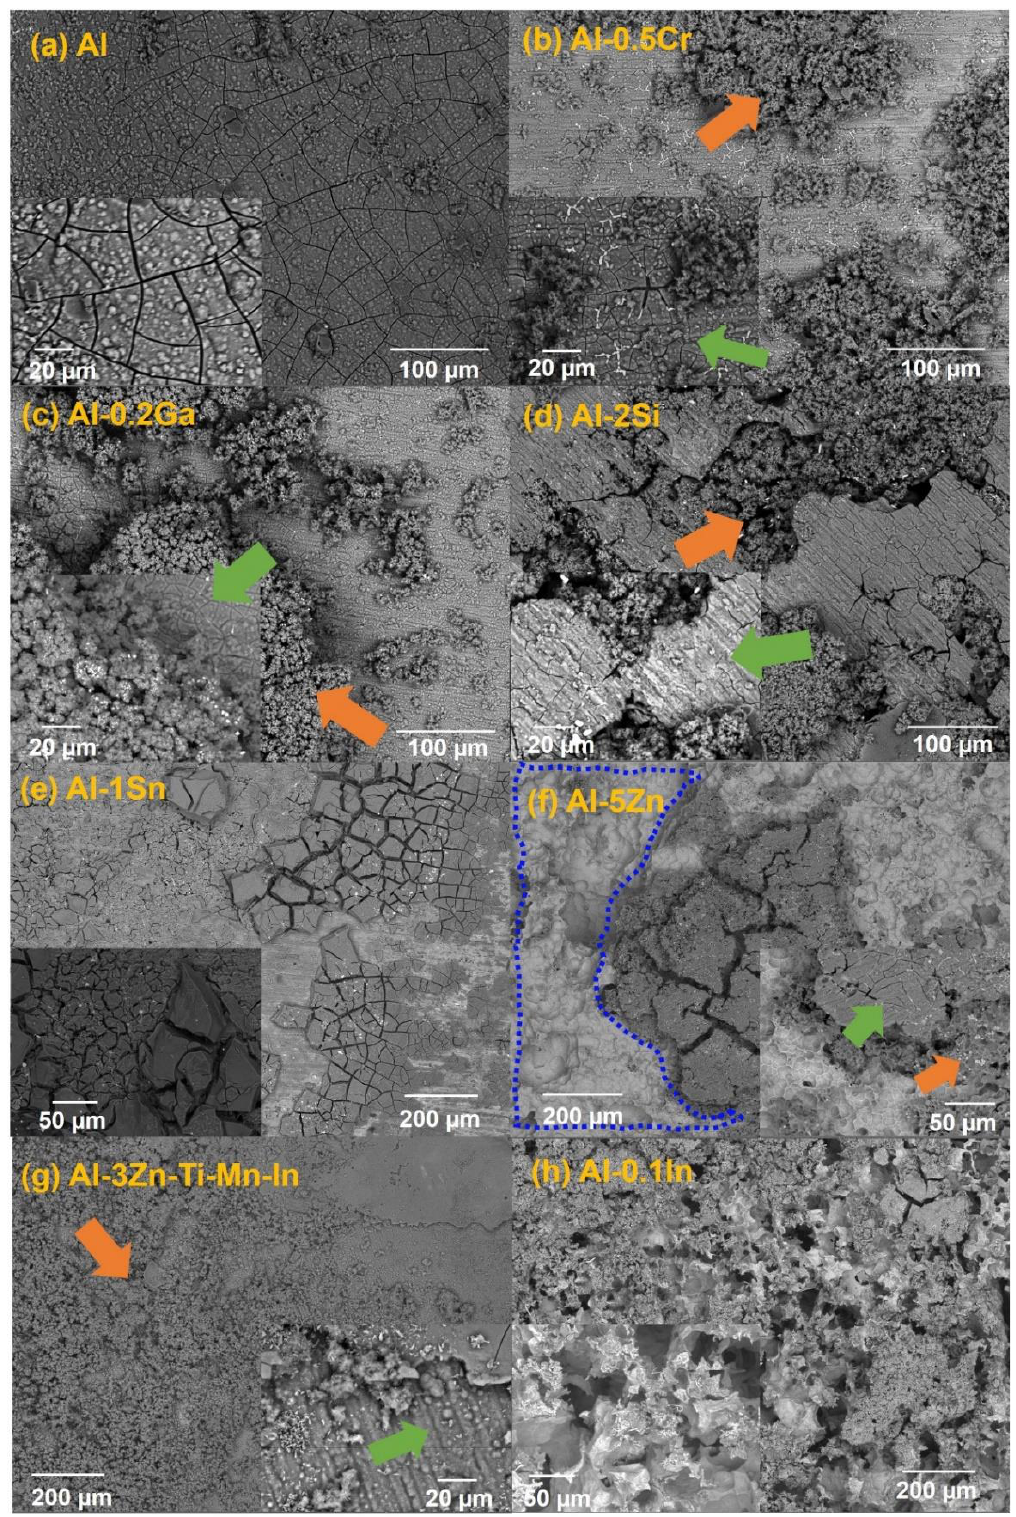
Figure 9. Corrosion product film formation after galvanic test (at high and low magnifications) of ( a ) Al, ( b ) Al-0.5Cr, ( c ) Al-0.2Ga, ( d ) Al-2Si, ( e ) Al-1Sn, ( f ) Al-5Zn, ( g ) Al-3Zn-Ti-Mn-In and ( h ) Al-0.1In, where green arrows represent a compact corrosion-product layer, while orange arrows show a porous corrosion-product layer and the blue dash line exhibits an corrosion-product-free region.